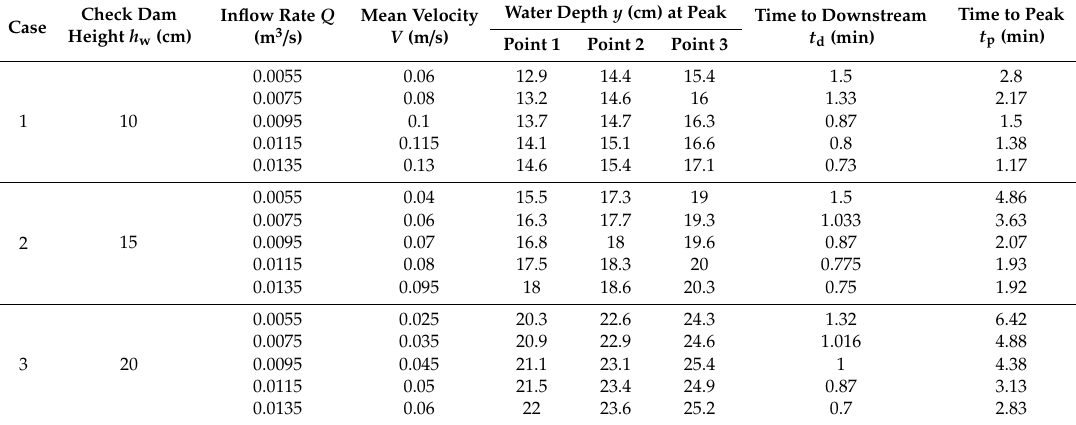
Table 2. The flow characteristics estimated for di ff erent experimental